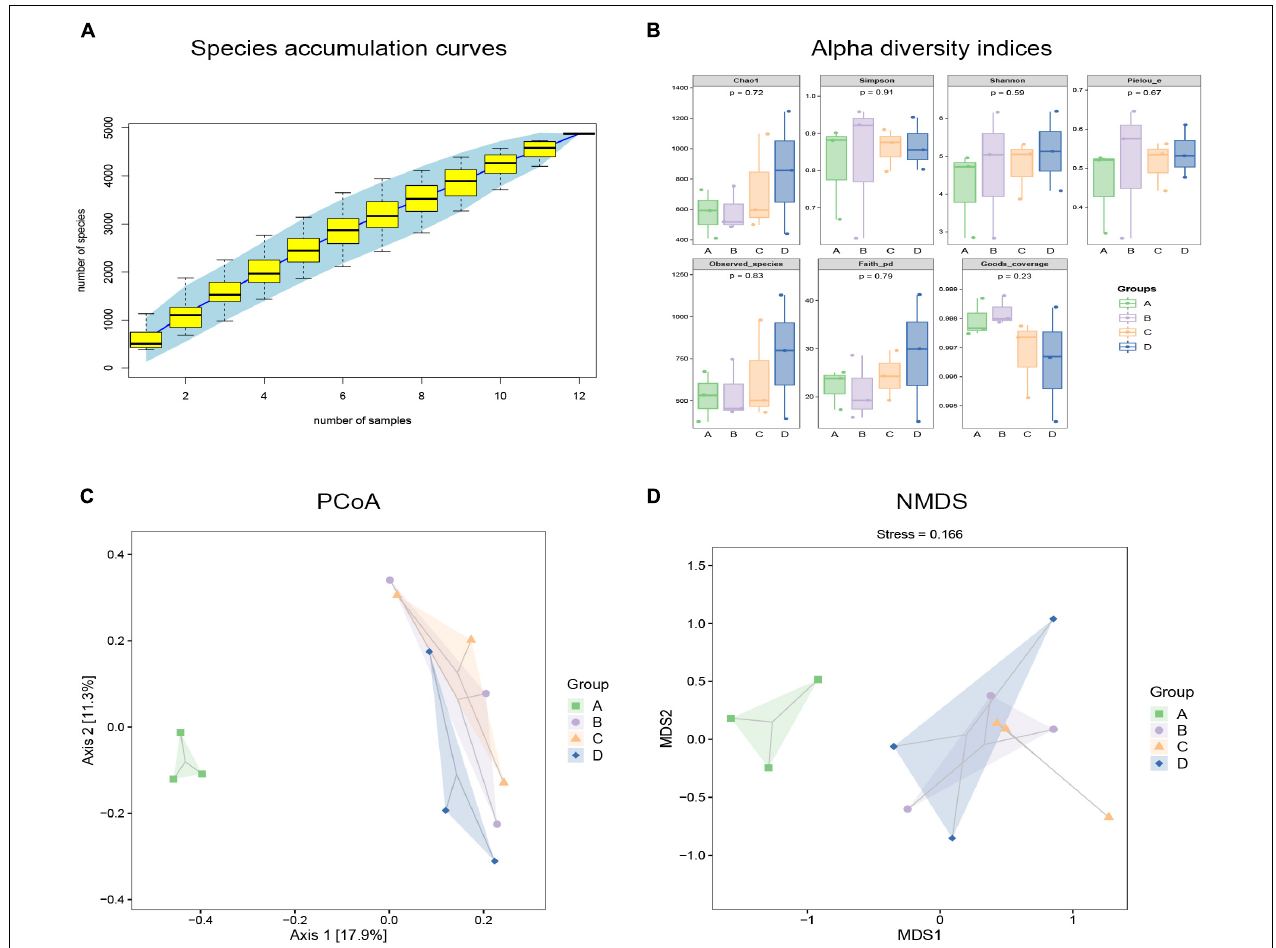
FIGURE 3 | Analyze each group’s gut microbiota richness and diversity. (A) Specaccum species accumulation curve. The X -axis represents sample size, and Y -axis stands for the number of observed species (ASV/OTU). The blue part is the confidence interval of the curve ( n = 3). (B) Alpha diversity indices of fecal samples in each group ( n = 3). Principal coordinate analysis (PCoA; C) and non-metric multidimensional scaling (NMDS; D) based on OTU abundance ( n = 3). The oval dotted circle represents the 95% confidence region. A: CON group; B: DSS group; C: L-BBr group; and D: H-BBr